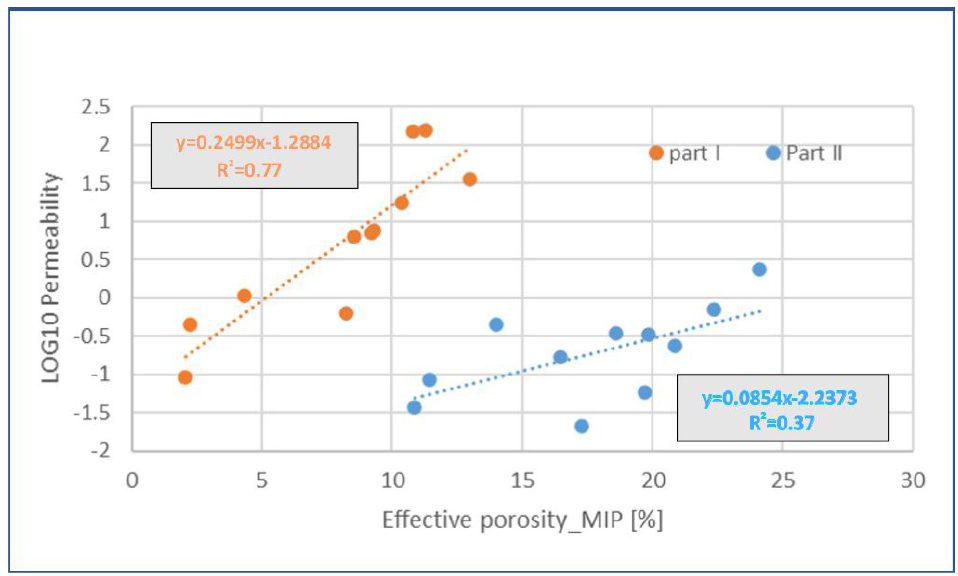
Figure 10. Relation between permeability and porosity from laboratory measurements. G-6 bore- hole.